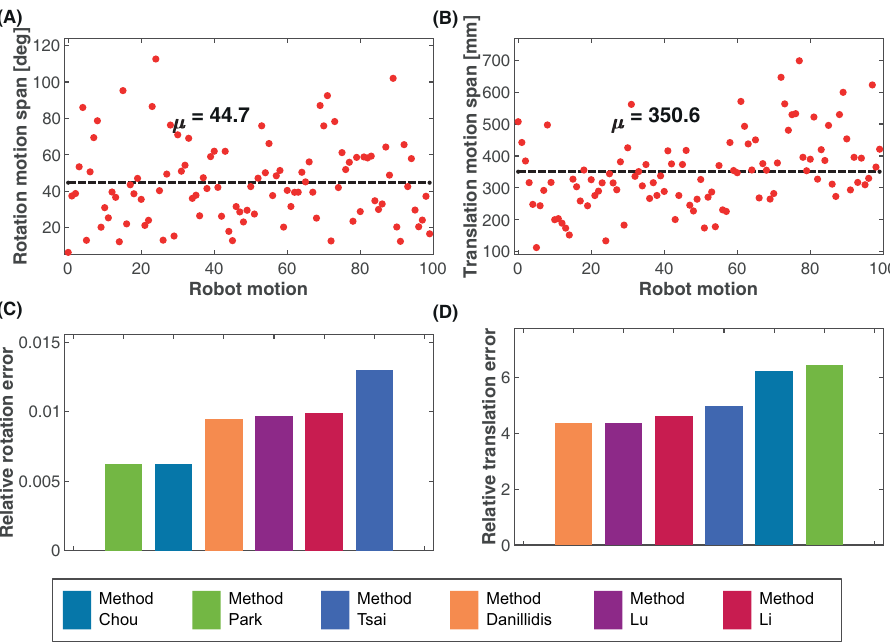
Fig 8. Random rotation and translation motion of the robot during data collection. (A) Rotation motion span, mean, μ = 44.7 deg. (B) Translation motion span, mean μ = 350.6 mm. (C) Relative rotation error. (D) Relative translation error.